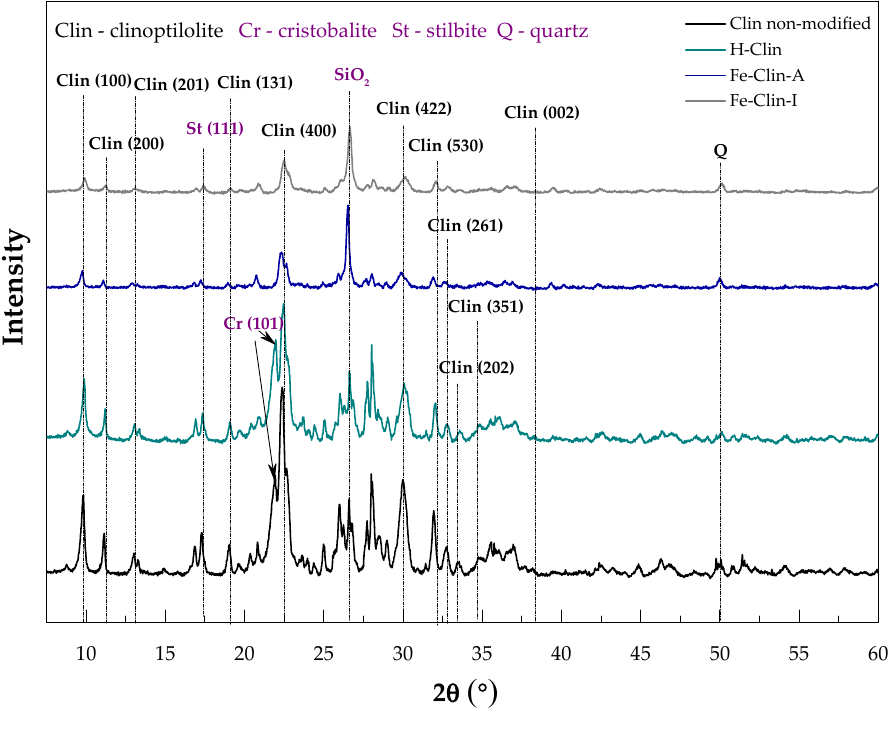
Figure 1. X-ray diffraction method (XRD) patterns of non-modified clinoptilolite, protonated form of clinoptilolite prepared at AGH (H-Clin), clinoptilolite modified with iron (Fe-Clin-A, Fe-Clin-I).